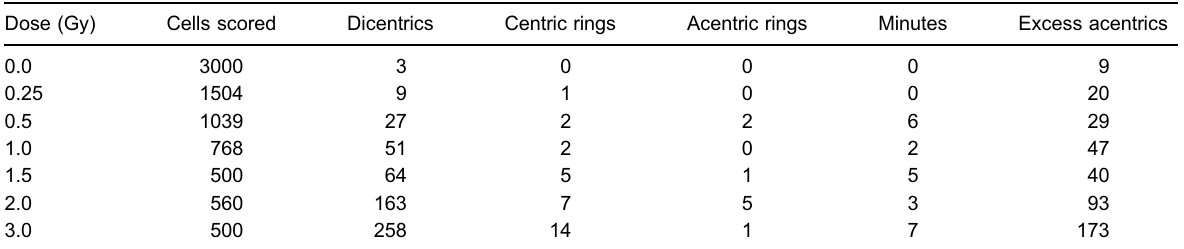
Table 1. Cytogenetic effects of acute LINAC X-ray irradiation in lymphocytes from human blood samples. Dose (Gy) Cells scored Dicentrics Centric rings